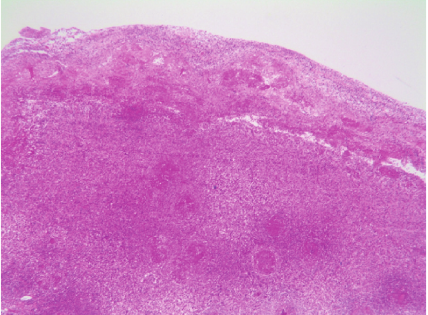
Figure 1: Haematoxylin and Eosin (H&E) stain of the synovial biopsy showing foci of granulomatous inflammation (20x magnifi- cation).